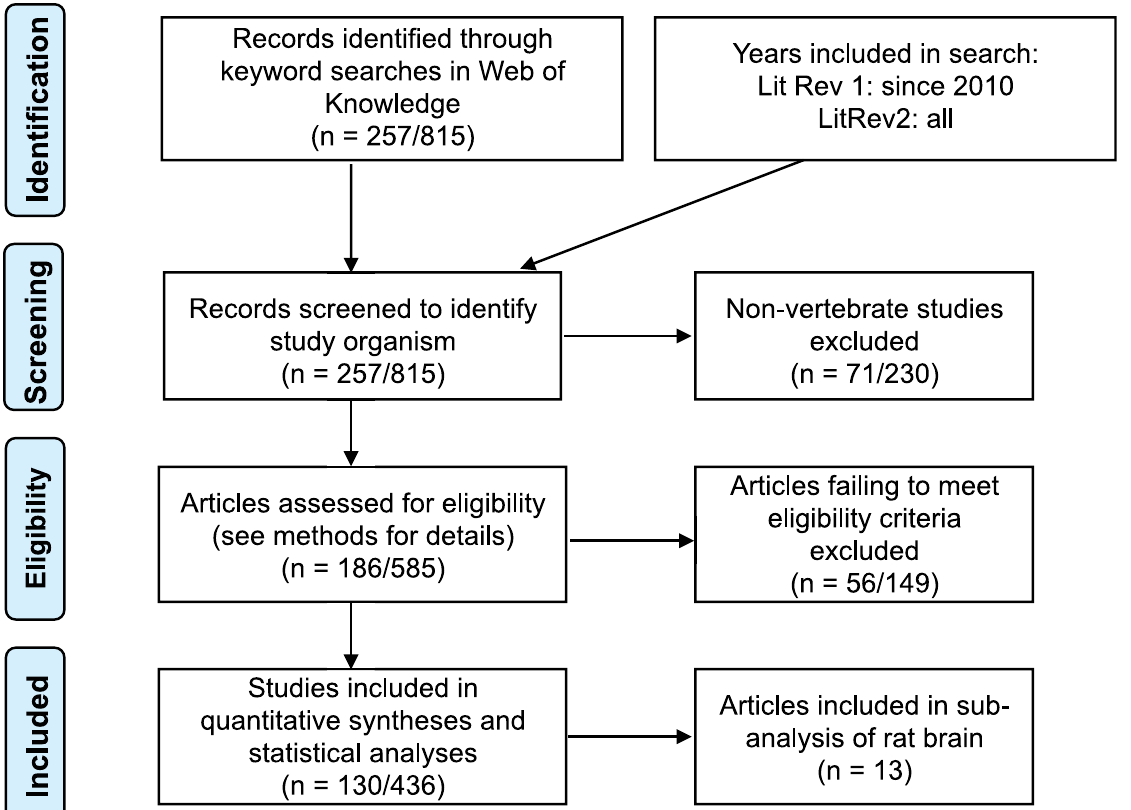
Fig 1. PRISMA flowchart. The number (n) of studies included and excluded at various stages of the quantitative review process, where numbers are specified as LitRev1/LitRev2.